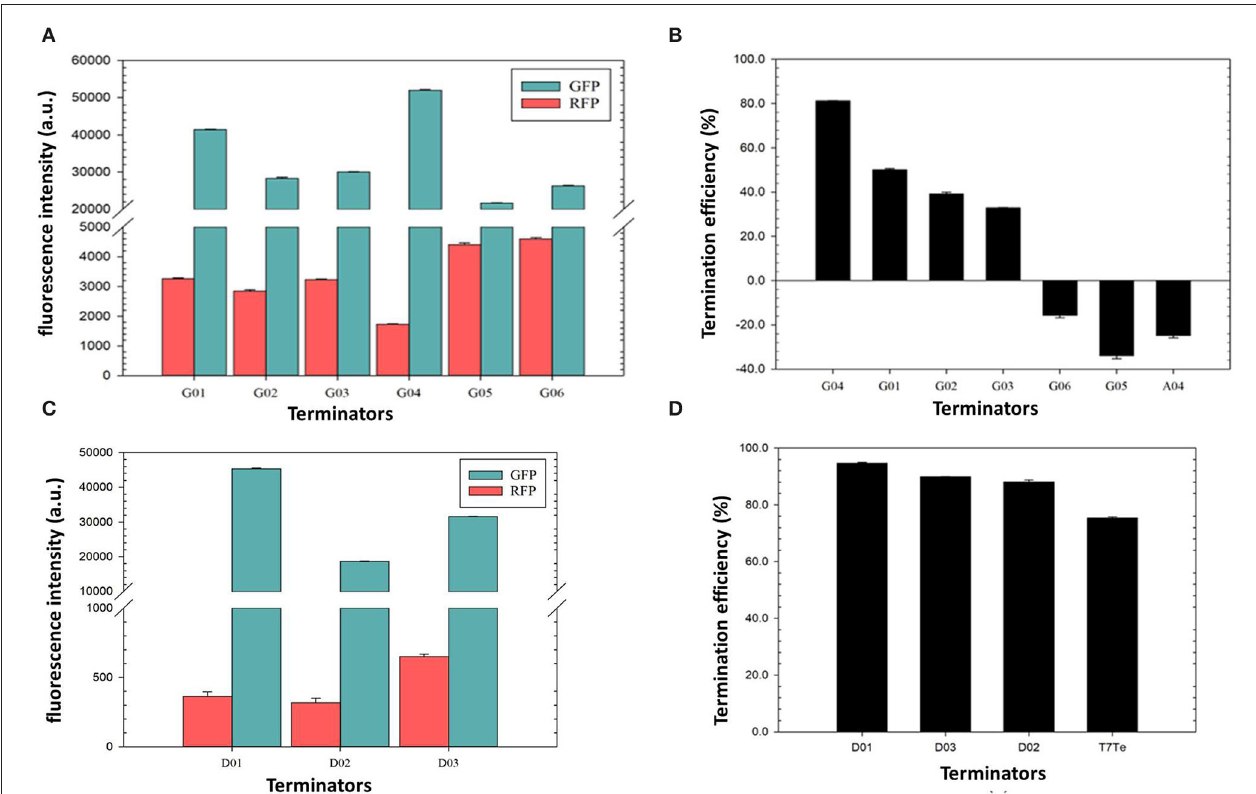
FIGURE 4 | Verification of the termination efficiency of engineered terminators based on the “main contributors” strategy in H. bluephagenesis TD01. (A,C) : The normalized fluorescence intensities of the GFP and the RFP in the recombinant H. bluephagenesis TD strains harboring six rationally designed terminators based on A04 scaffold (A) and three de novo designed terminators (C) . (B,D) : The termination efficiencies of rationally designed terminators based on A04 scaffold (B) and de novo designed terminators (D)